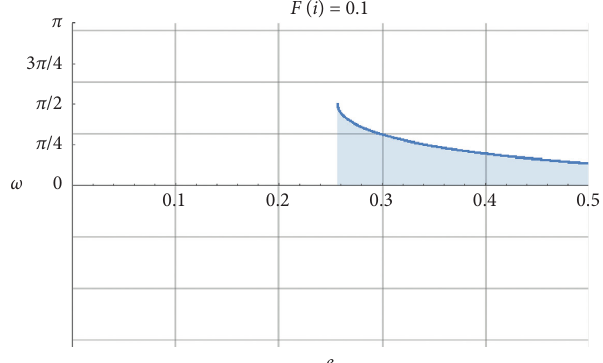
Figure 7: The curve ω ( e ) at which _ e � _ i � 0 for F ( i ) � 0.01.